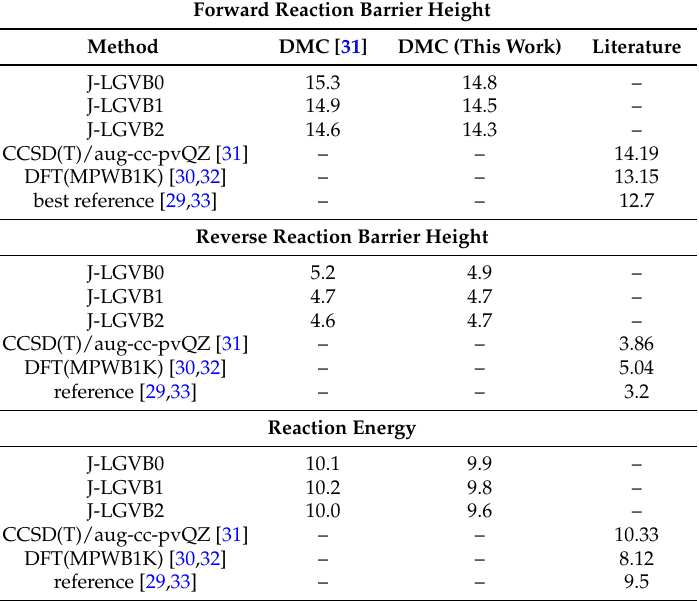
Table 3. Barrier heights and reaction energies (kcal/mol) for the hydrogen transfer NH 2 + H 2 O → NH 3 + OH at various level of calculation and comparison with literature data. Statistical error is about 0.1